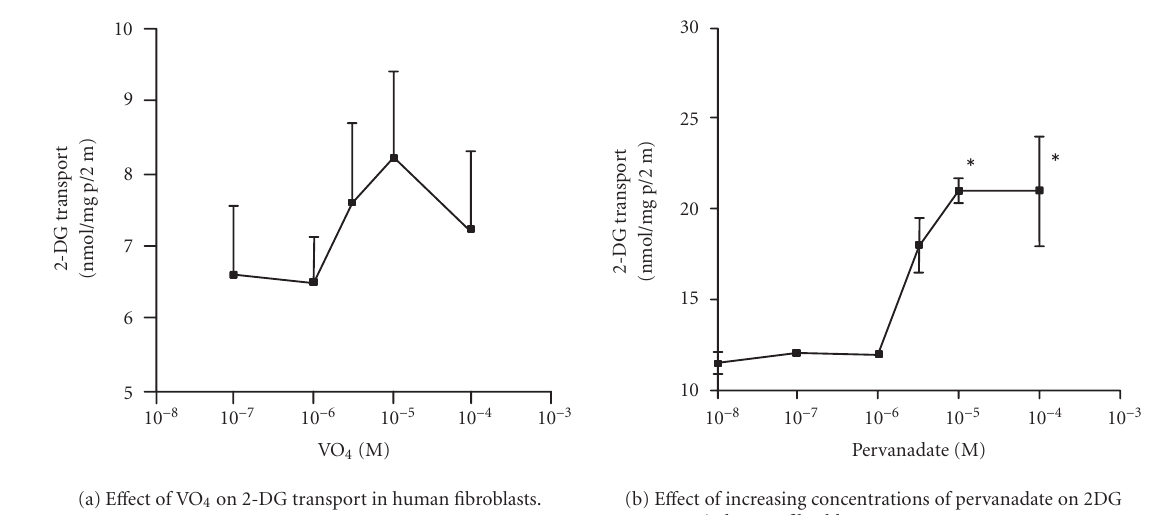
(a) E ff ect of VO 4 on 2-DG transport in human fibroblasts. (b) E ff ect of increasing concentrations of pervanadate on 2DG transport in human fibroblasts.